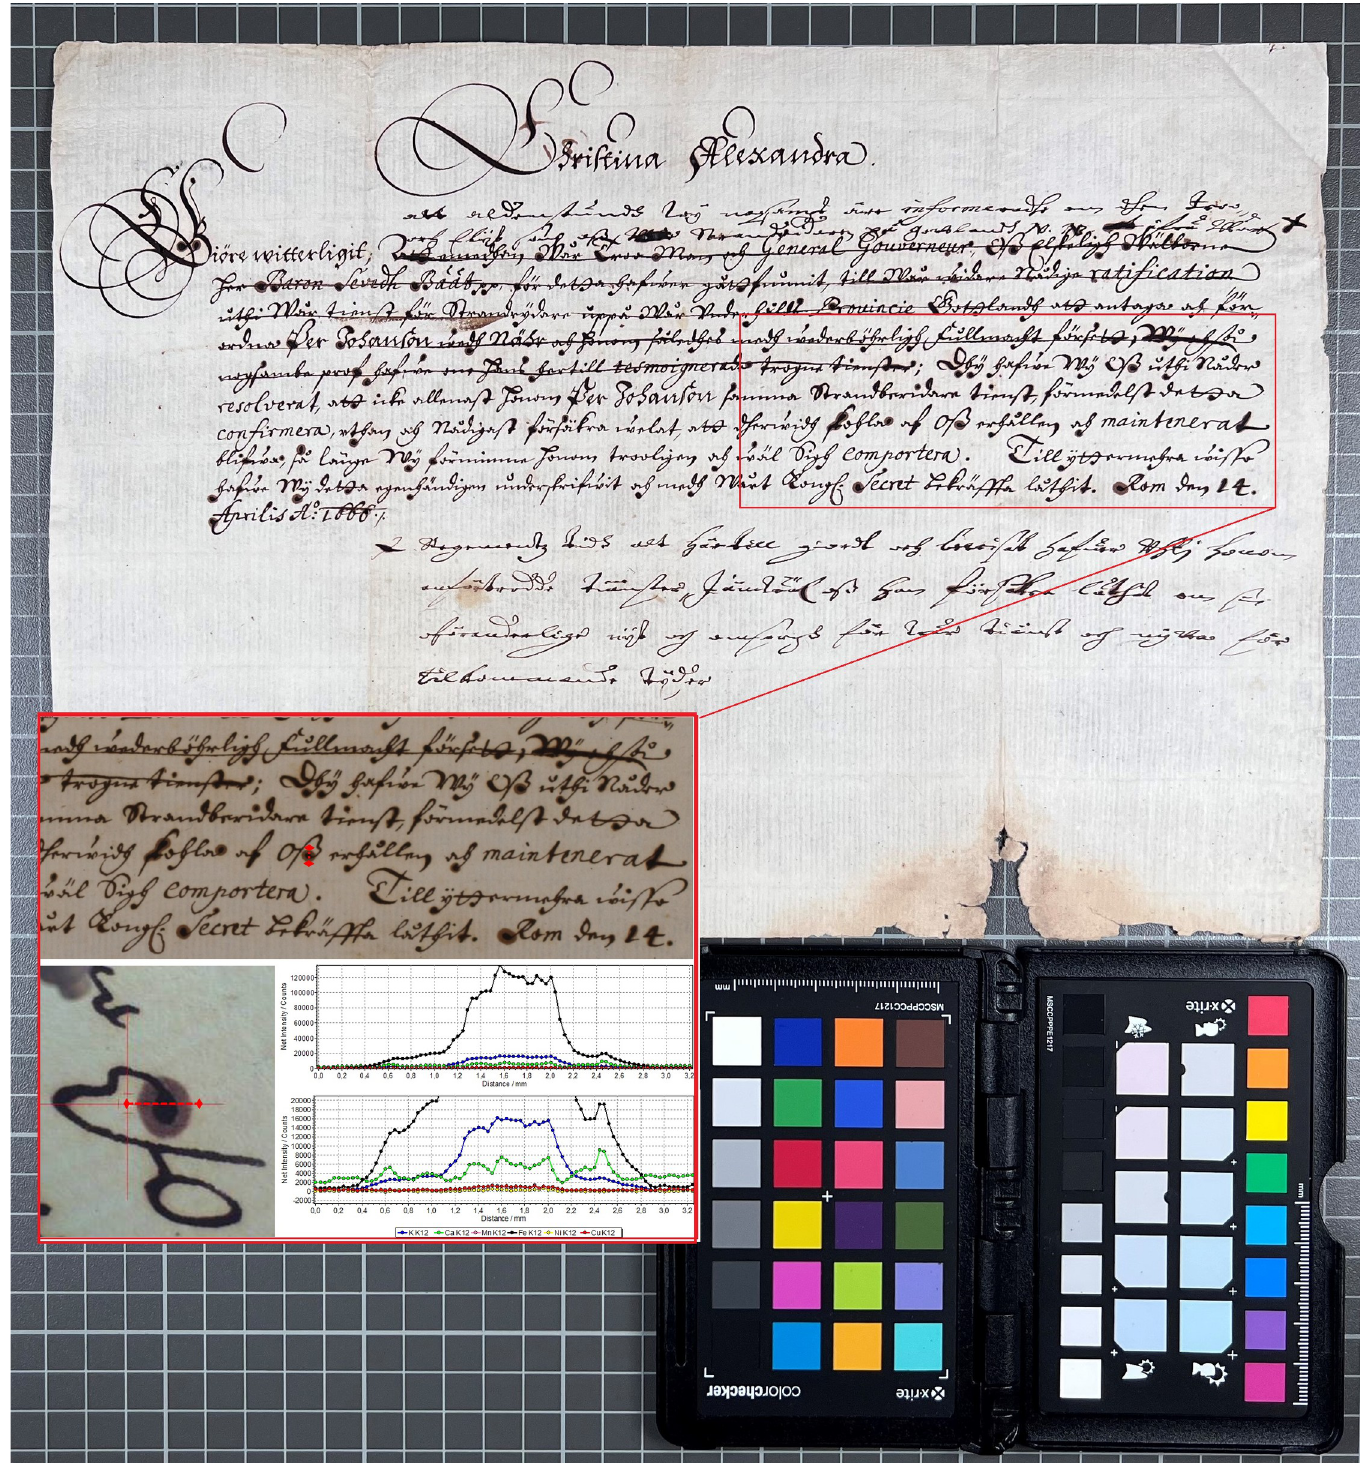
Fig 23. XRF line scan (82 points) from K396 266 over Christina’s ink line with halo, displaying the migration of iron, calcium and potassium from the ink into the paper.